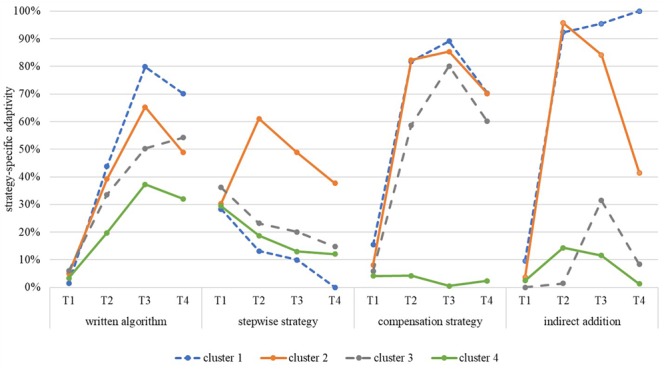
Result of the cluster analysis.